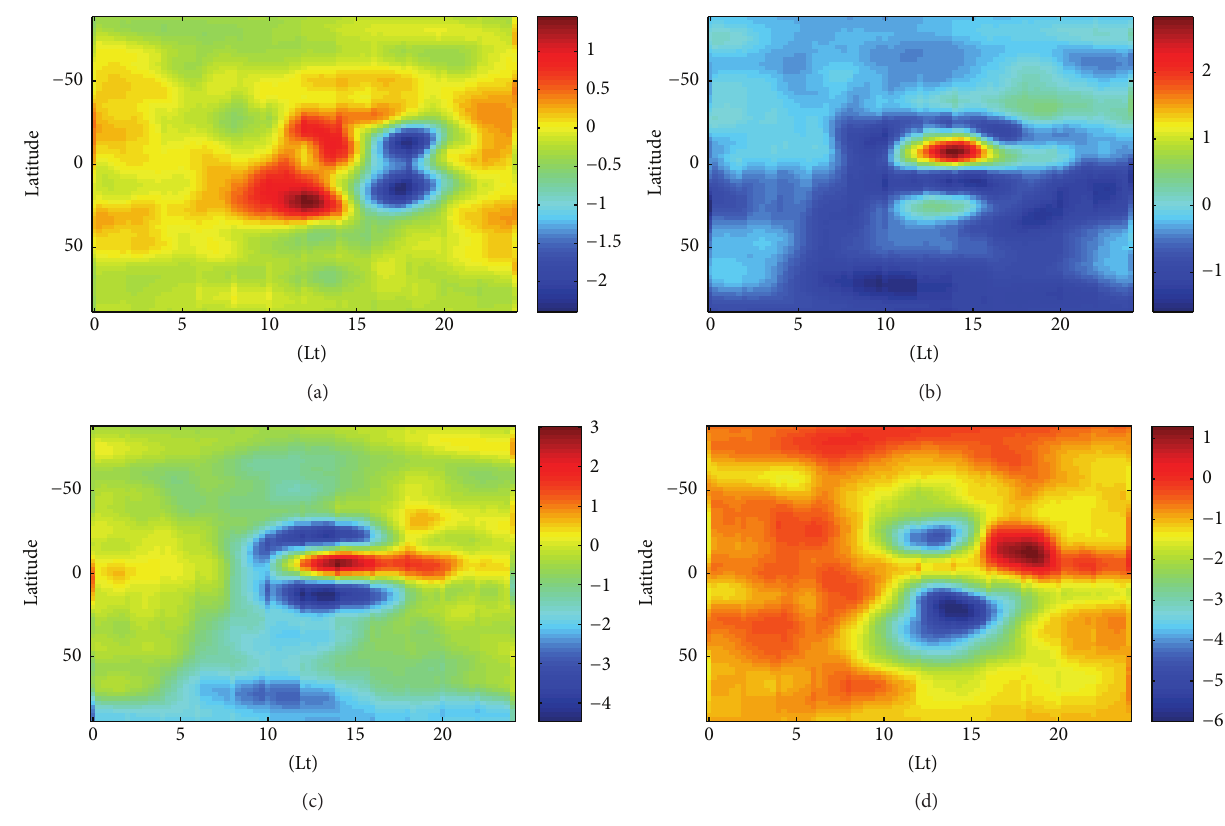
Figure 3: Error distributions by direct forecasting.